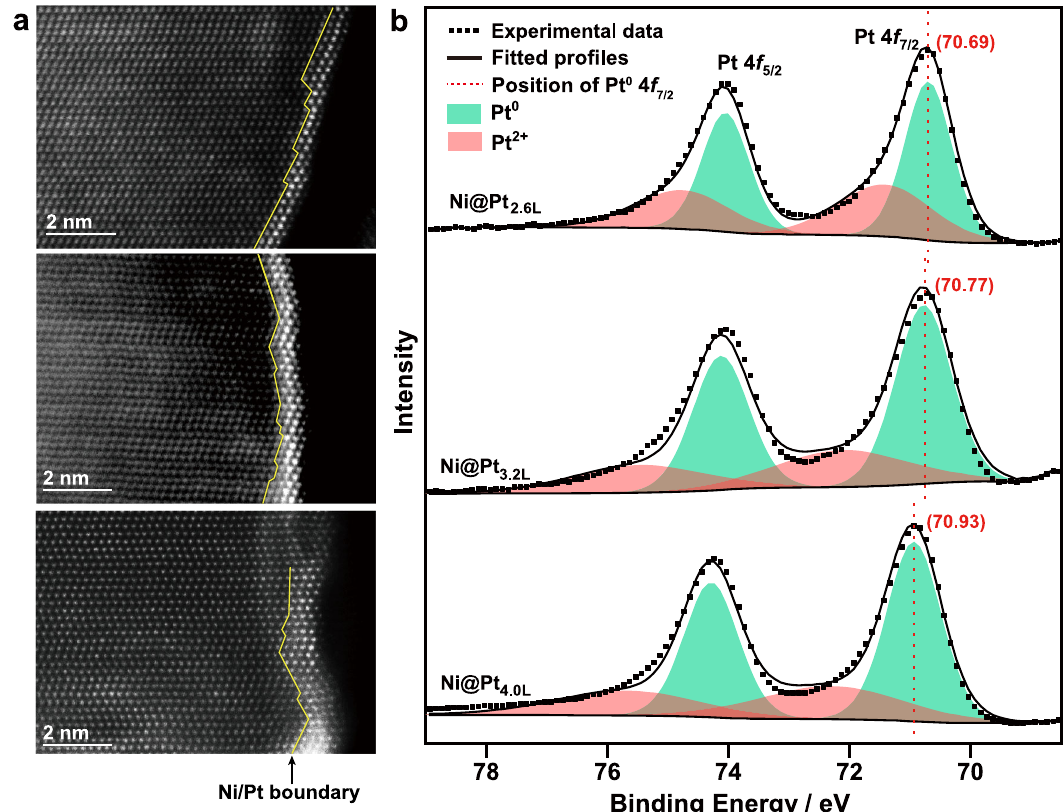
Fig. 3 | Thickness-dependent electronic properties of the coherent hcp- Pt skins on Ni substrates. a HAADF-STEM images of the hcp -Ni@Pt 2.6L (top), hcp -Ni@Pt 3.2L (middle), and hcp -Ni@Pt 4.0L (bottom) nanobranches. b Pt 4 f XPS spectra of the hcp -Ni@Pt n L nanobranches fi tted by 4 f 7/2 and 4 f 5/2